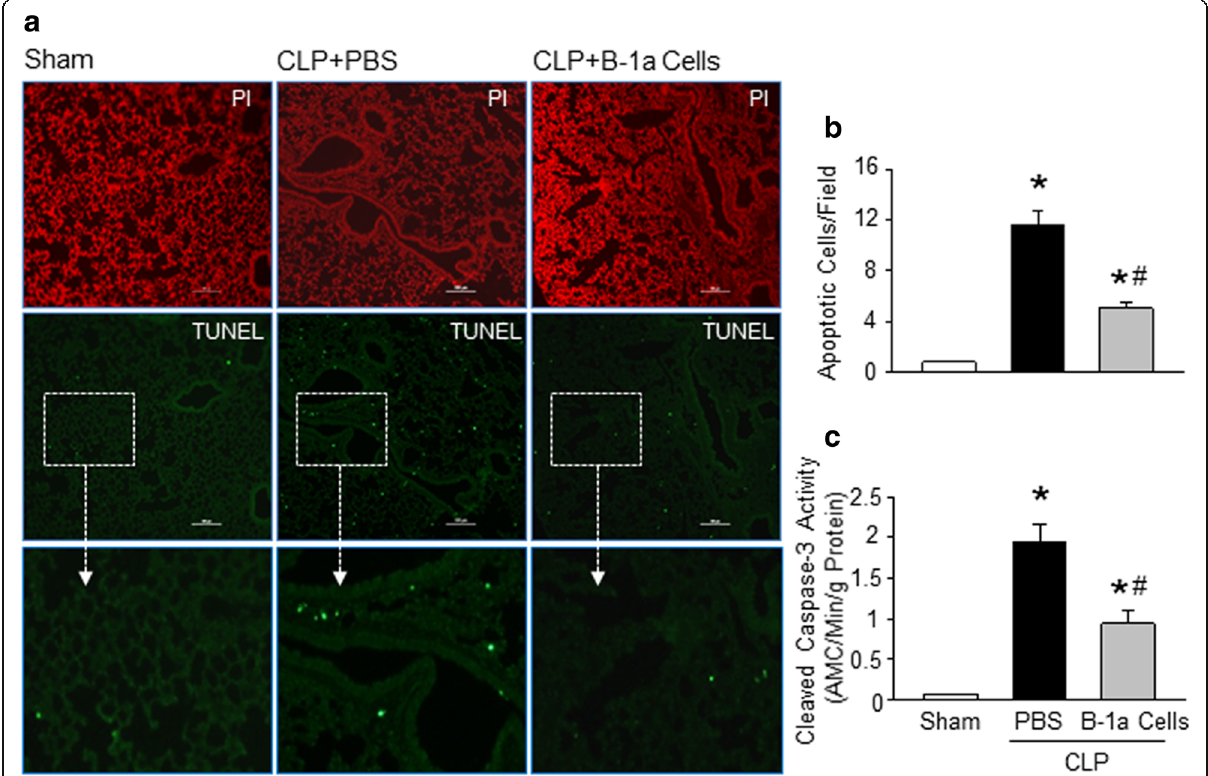
Fig. 4 Treatment with B-1a cells attenuates apoptosis in lungs after sepsis. After 20 h of CLP, lung tissues were collected from PBS or B-1a cell treated mice. a Lung tissue sections were prepared for TUNEL staining shown in green, and for nuclear staining using PI shown in red. Representative images at × 100 original magnification are shown. Scale bar, 100 μ m. b TUNEL positive apoptotic cells were counted at 18 random fields in a blinded fashion, and the average numbers of cells per field are shown. c Cleaved Caspase-3 activity in total lung tissues of sham-operated, and PBS or B-1a cell-treated CLP mice was determined. Data are expressed as means ± SE ( n = 6 mice/group) and compared by one-way ANOVA and SNK method ( * p < 0.05 vs. shams; # p < 0.05 vs. PBS-treated CLP mice). CLP, cecal ligation and puncture; TUNEL,